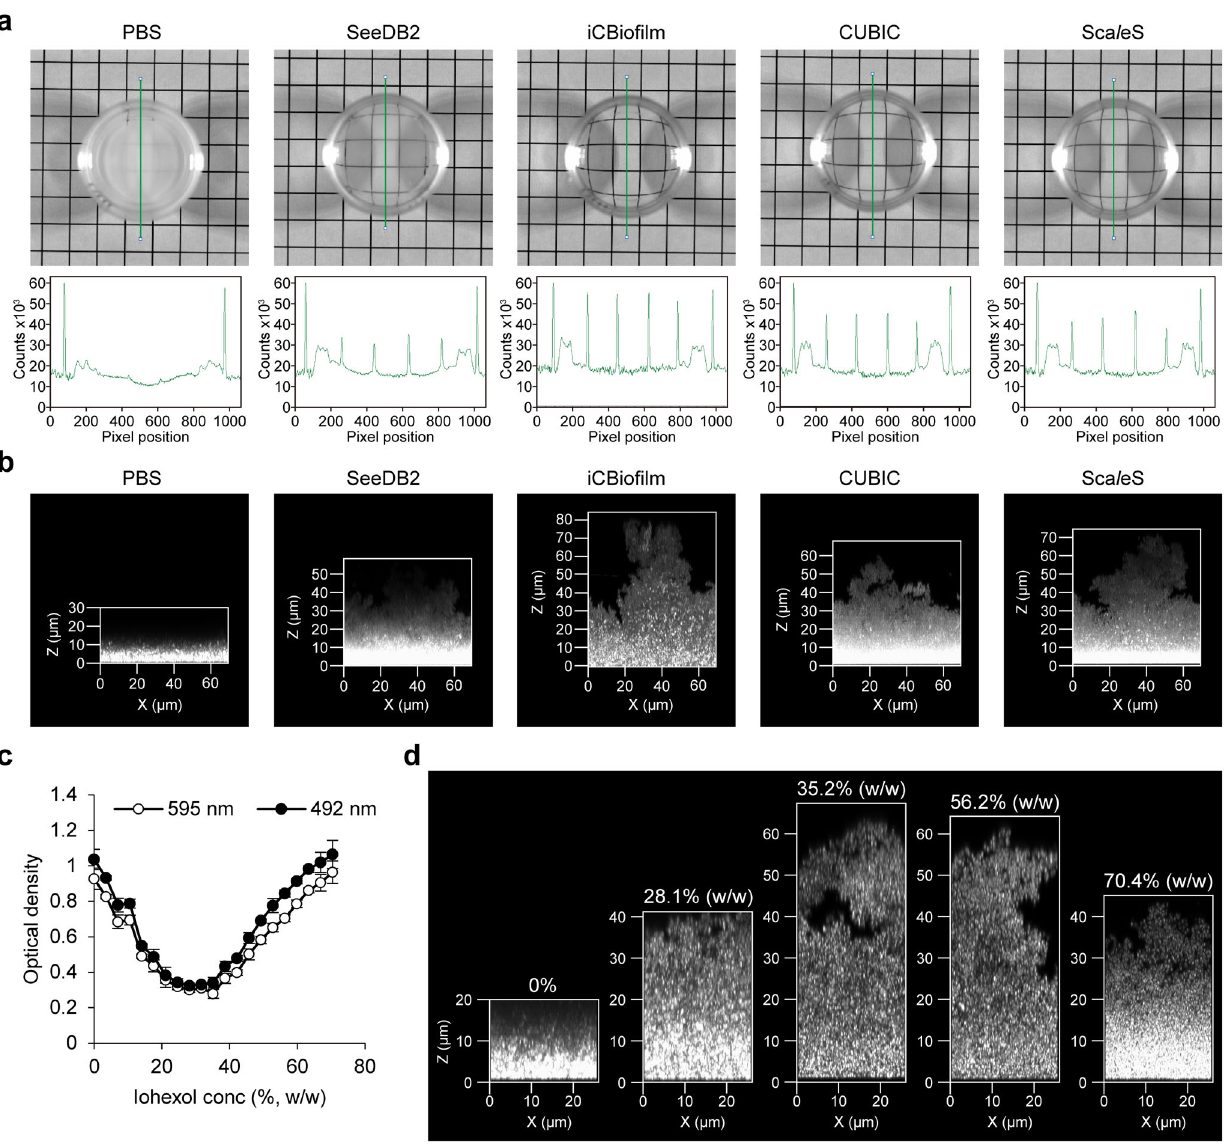
Fig. 1 Development of the iCBio fi lm method. a Photographs of MR23 bio fi lms on a grid pattern-printed paper as a background was obtained using ImageQuant for transmission. Plot pro fi les for the bio fi lms treated with the indicated tissue-clearing reagents are also shown in the lower panels. The bio fi lm treated with phosphate-buffered saline (PBS) was used as the control. The green line in the upper image indicates the corresponding location of the plot pro fi le in the lower panel, respectively. b Typical side views of the MR23 bio fi lms stained with thio fl avin T (ThT). An LSM880 confocal laser scanning microscope with a ×40 oil immersion objective lens and an Airyscan super-resolution unit (Carl Zeiss, Oberkochen, Germany) was used to acquire z-stacks of the stained bio fi lms every 0.22 μ m. c Optical density vs iohexol concentration for MR23 bio fi lms. Means and standard deviations from three measurements are shown. d Typical side views of fi xed MR23 bio fi lms stained with FM1-43 and soaked in the indicated iohexol solutions. LSM880 confocal laser scanning microscope with ×63 objective lens and Airyscan super-resolution unit was used to acquire z-stacks of the stained bio fi lms every 0.18 μ m. X and Z represent width and thickness,